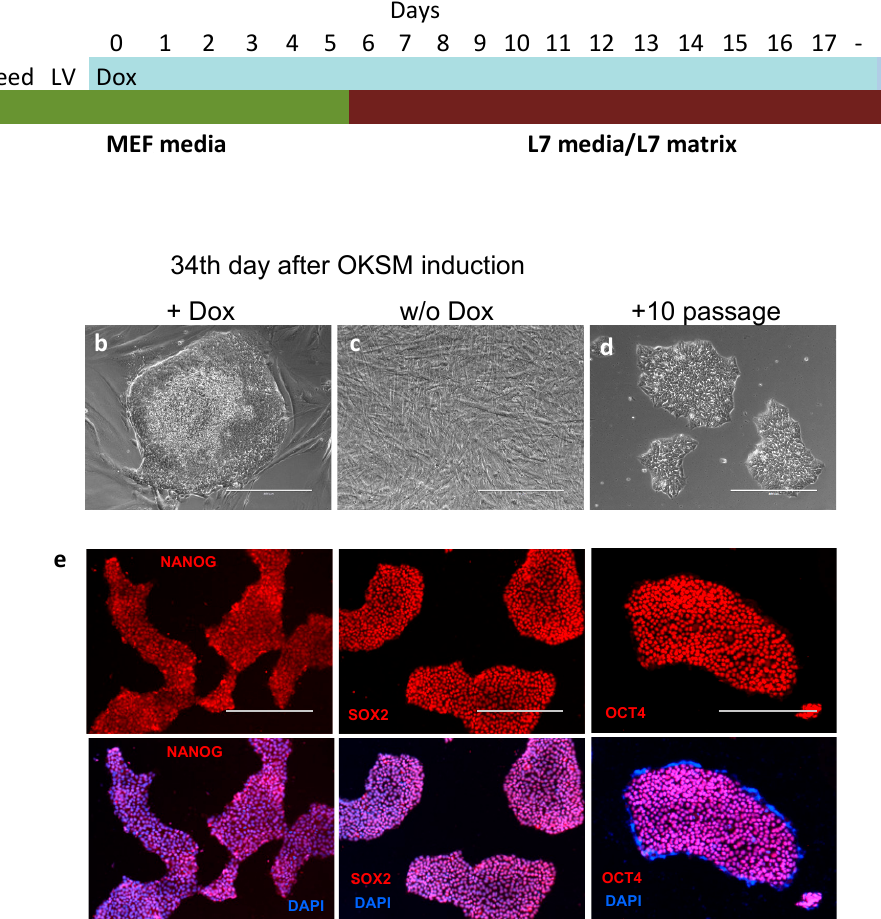
Figure 1. Generation of human pluripotent stem cells (hiPSCs) from human mesenchymal stem cells (hMSCs). ( a ) OKSM cassette expression was induced by Dox (2 µ g/mL) on day 0, and on day 6 cells medium was changed to the L7. Distinctive hiPSC clones were observed on day 28. Representative images of ( b ) hiPSC clone on day 34 after OKSM induction, ( c ) uninfected hMSCs cultured for the same period of time, and ( d ) hiPSCs after 10 passages in culture. ( e ) hiPSCs cultured for 7 passages retain pluripotent characteristics, such as expression of NANOG, SOX2, and OCT4 marker genes (red). Scale bar represents 400 μ m.